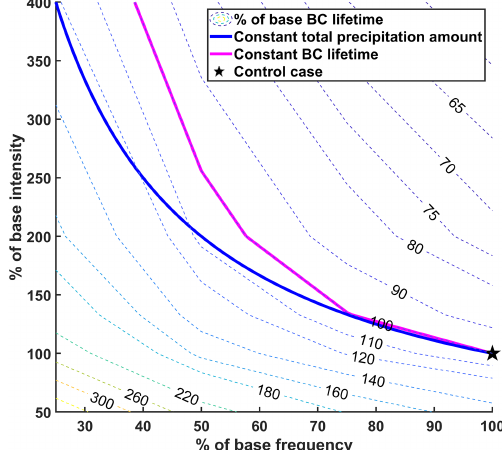
Figure 2. Model-calculated BC atmospheric lifetime as a function of precipitation intensity and frequency. The dashed contour lines indicate the atmospheric lifetimes of the black carbon aerosols from the interpolation of 20 cases, which show the potential changes of BC lifetimes from the base BC lifetime (in the control run) driven by the changes of precipitation intensity and frequency. The blue solid line represents a total precipitation equal to that of the base simulation (control run). The pink solid line indicates the conditions leading to atmospheric black carbon aerosol lifetimes that match the base simulation (control